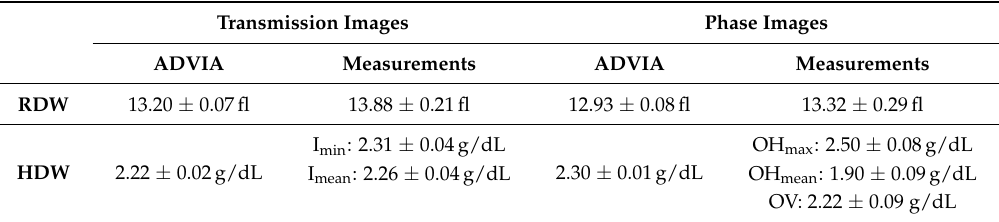
Table 2. Cellular volume distribution width (RDW) and cellular hemoglobin distribution width (HDW) comparisons of the reference system Siemens ADVIA 2120i and our measurements for two example samples. Comparison of the same sample between Siemens ADVIA 2120i and intensity measurements and another sample for comparing the reference method and our phase